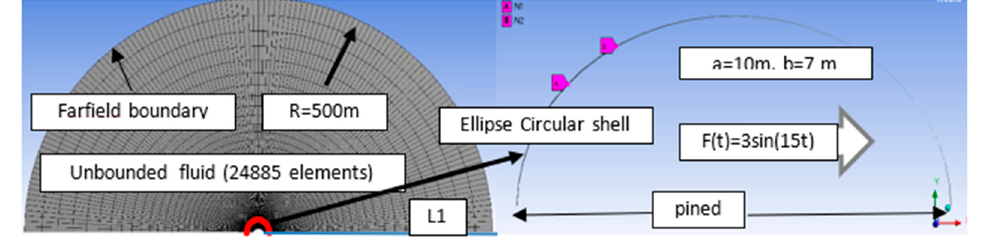
Figure 11. Schematic diagram of the FSI mode. Table 2. Parameters of the FSI